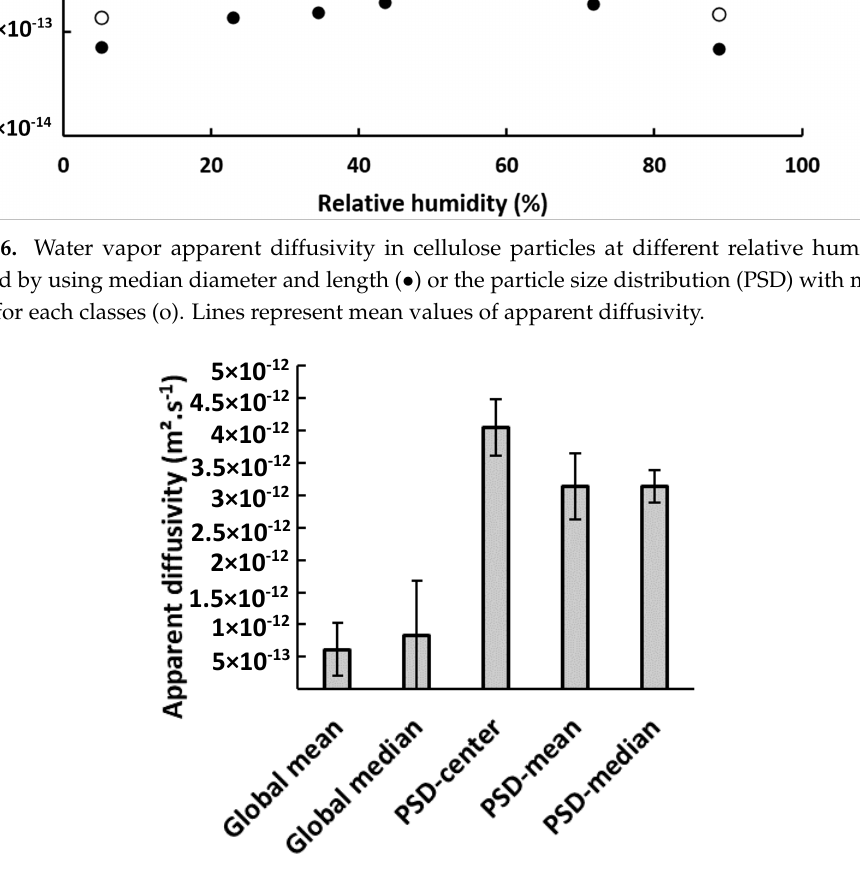
Figure 7. Apparent water vapor diffusivity in cellulose particles estimated for different shape descriptors (bin class of 10 µm × 10 µm).